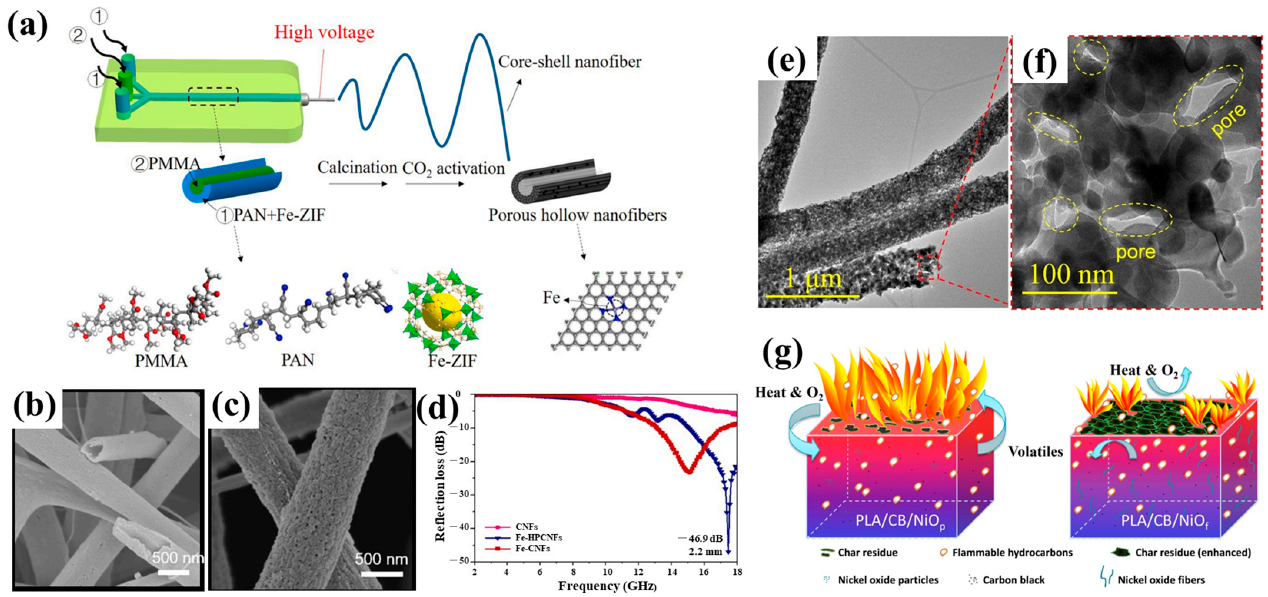
Figure 14. ( a ) Schematic of fabricating Fe-HPCNFs; ( b , c ) SEM photos of Fe-HPCNFs before and after liquid nitrogen cooling; ( d ) reflection loss curves for CNF, Fe-CNF, and Fe-HPCNF materials. Reprinted with permission from Ref. [175], Copyright 2022, Elsevier. ( e , f ) TEM and enlarged TEM images of porous NiO nanofibers; ( g ) the flame-retardant mechanism of PLA/CB/NiO p and PLA/CB/NiO f composites. Reprinted with permission from Ref. [178], Copyright 2020, Elsevier.